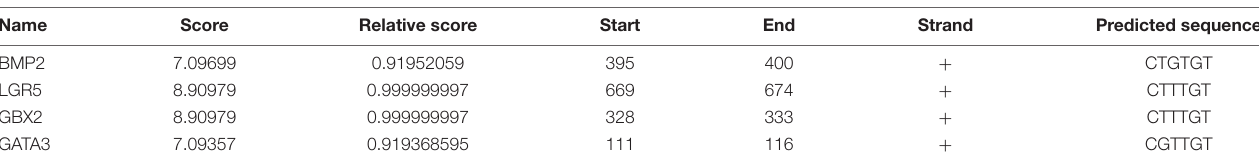
FIGURE 9 | Protein-protein interaction network of differentially expressed genes that interact with SOX10. The diamond represents SOX10. The circles indicate the proteins that interact with SOX10. Red circles represent the genes enriched in the GO term inner ear development, and cyan circles represent the genes enriched in the GO term inner ear morphogenesis. Lines represent the interaction relationship between two proteins. TABLE 4 | The SOX10 potential binding sites predicted in the candidate